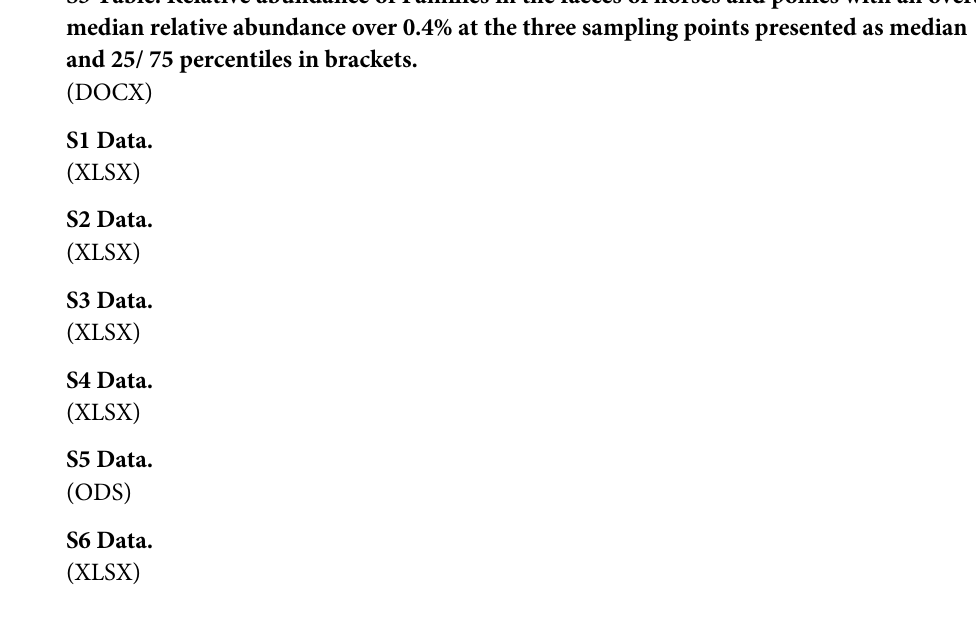
S1 Table. Coefficient of variation for the nutrient intake in horses and ponies two months prior to sampling point t1, t2, t3 and in between the three sampling points (CP: crude pro- tein, CL: crude lipid, CF: crude fibre, aNDFom: neutral detergent fibre). Data shown as %. S2 Table. Relative abundance of Phyla in the faeces of horses and ponies with an overall median relative abundance over 0.4% at the three sampling points presented as medians and 25/ 75 percentiles in brackets. S3 Table. Relative abundance of Classes in the faeces of horses and ponies with an overall median relative abundance over 0.4% at the three sampling points presented as median and 25/ 75 percentiles in brackets. S4 Table. Relative abundance of Orders in the faeces of horses and ponies with an overall median relative abundance over 0.4% at the three sampling points presented as median and 25/ 75 percentiles in brackets. S5 Table. Relative abundance of Families in the faeces of horses and ponies with an overall median relative abundance over 0.4% at the three sampling points presented as median and 25/ 75 percentiles in